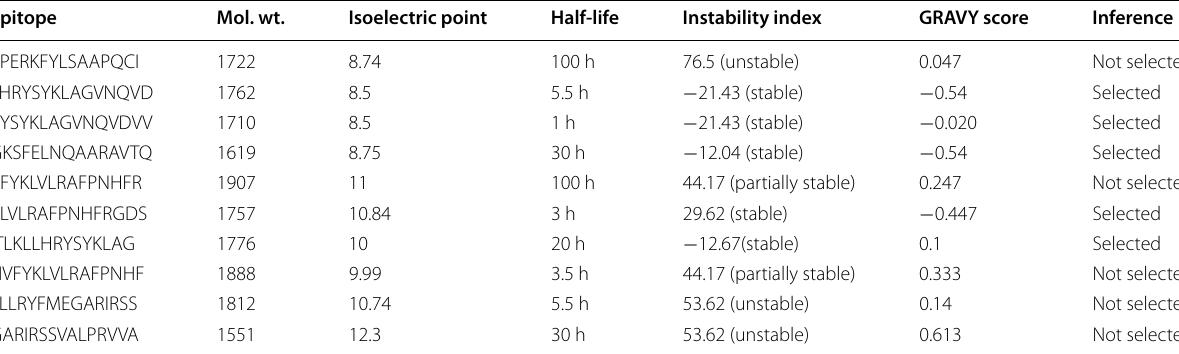
Table 7 Epitopes further screening based on physiochemical properties Epitope Mol.